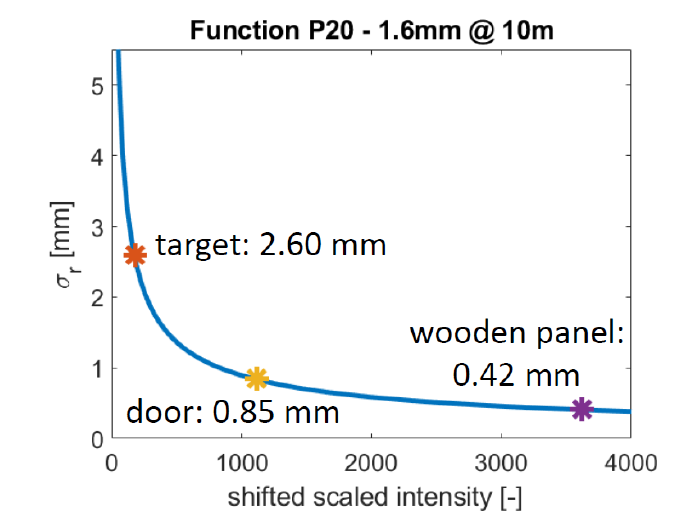
Figure 15. Corresponding range precision of the examples of Figure